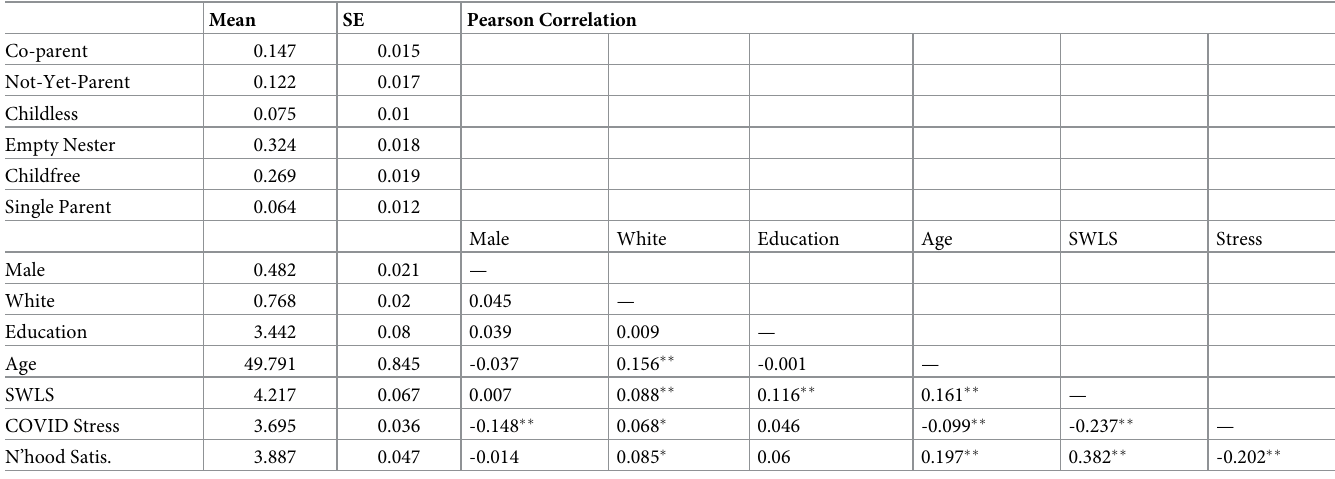
Table 1. Population